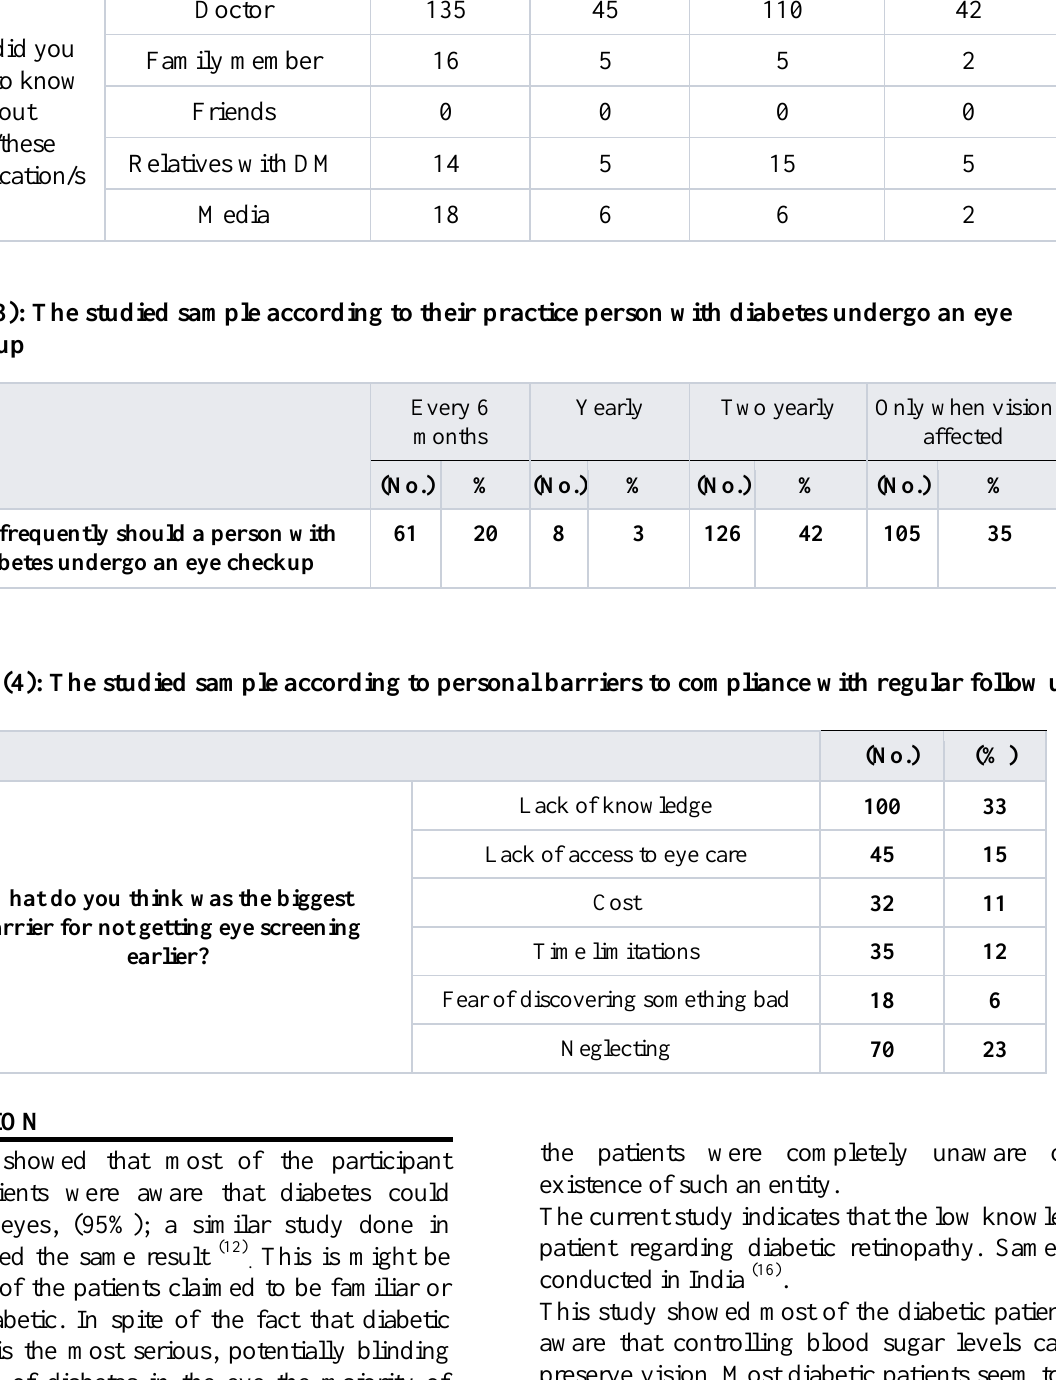
Male Female (No.) (%) (No.) (%)